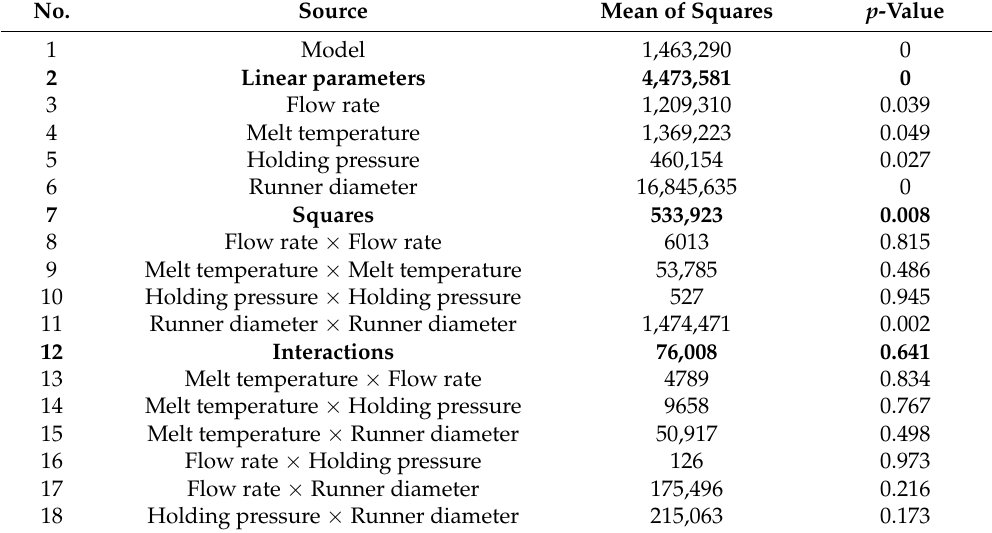
Table 6. Results of the second ANOVA